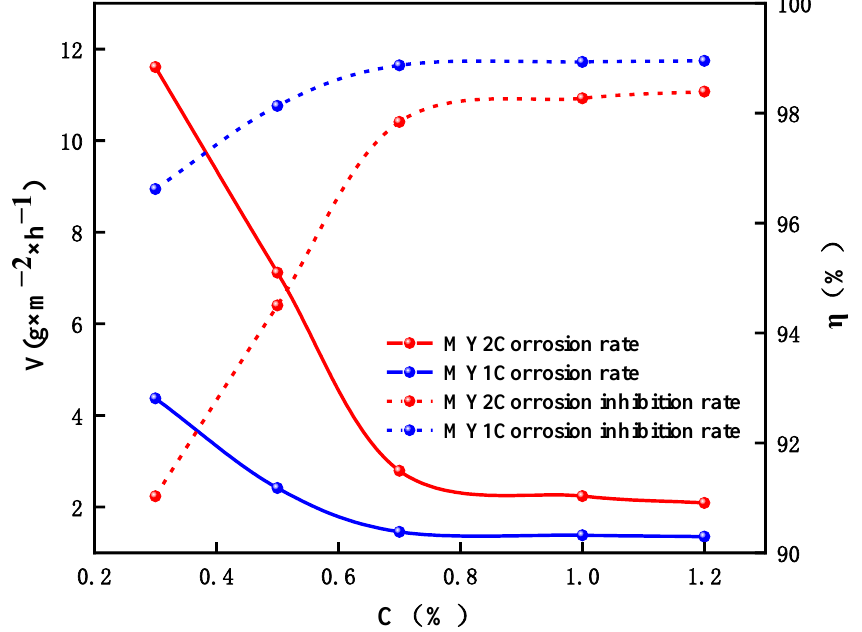
Figure 2. Corrosion rate and inhibition efficiency of N80 steel in various test solutions.